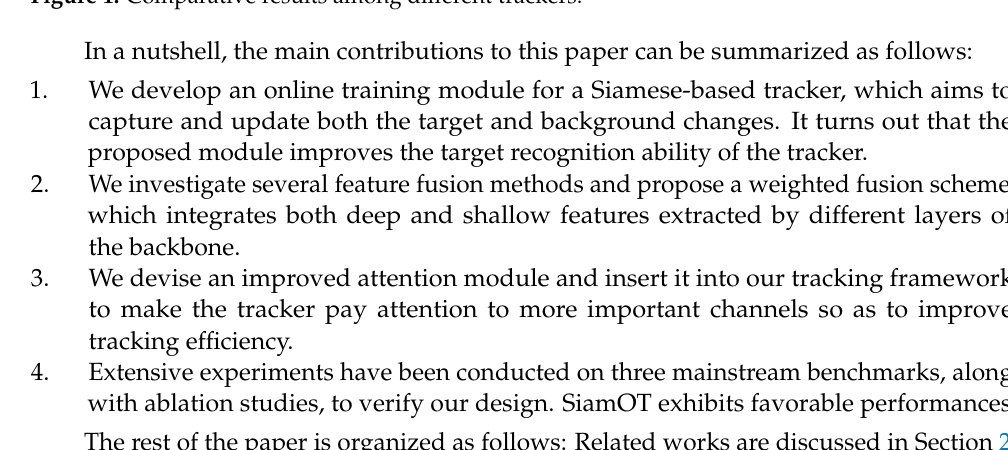
Figure 1. Comparative results among different trackers.